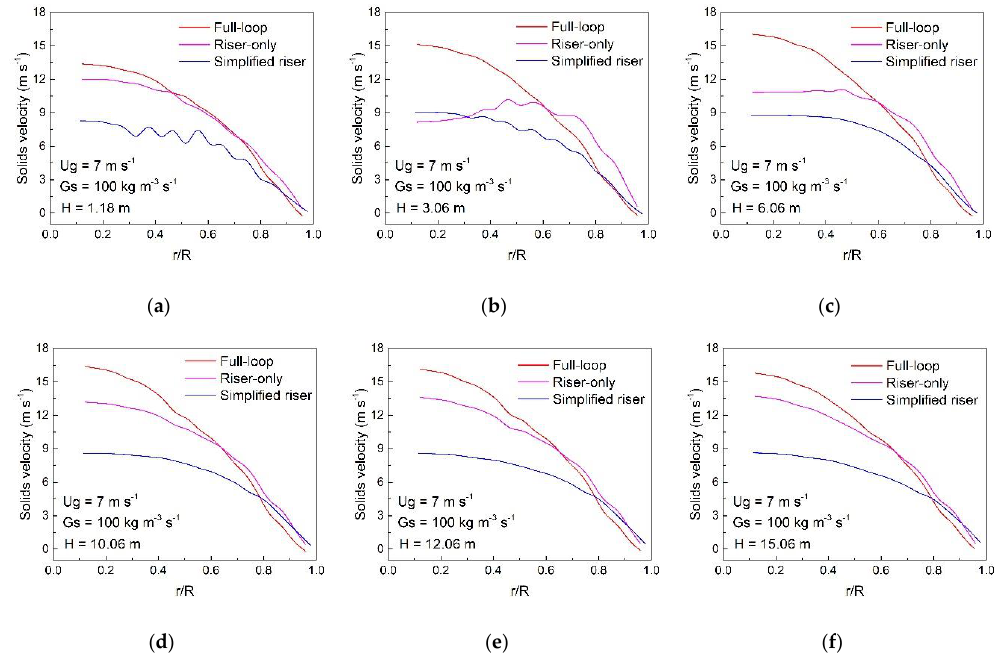
Figure 11. Comparison of time-averaged solid velocity in the riser among different simulations. ( a ) H = 1.18 m, ( b ) H = 3.06 m, ( c ) H = 6.06 m, ( d ) H = 10.06 m, ( e ) H = 12.06 m, ( f ) H = 15.06 m.